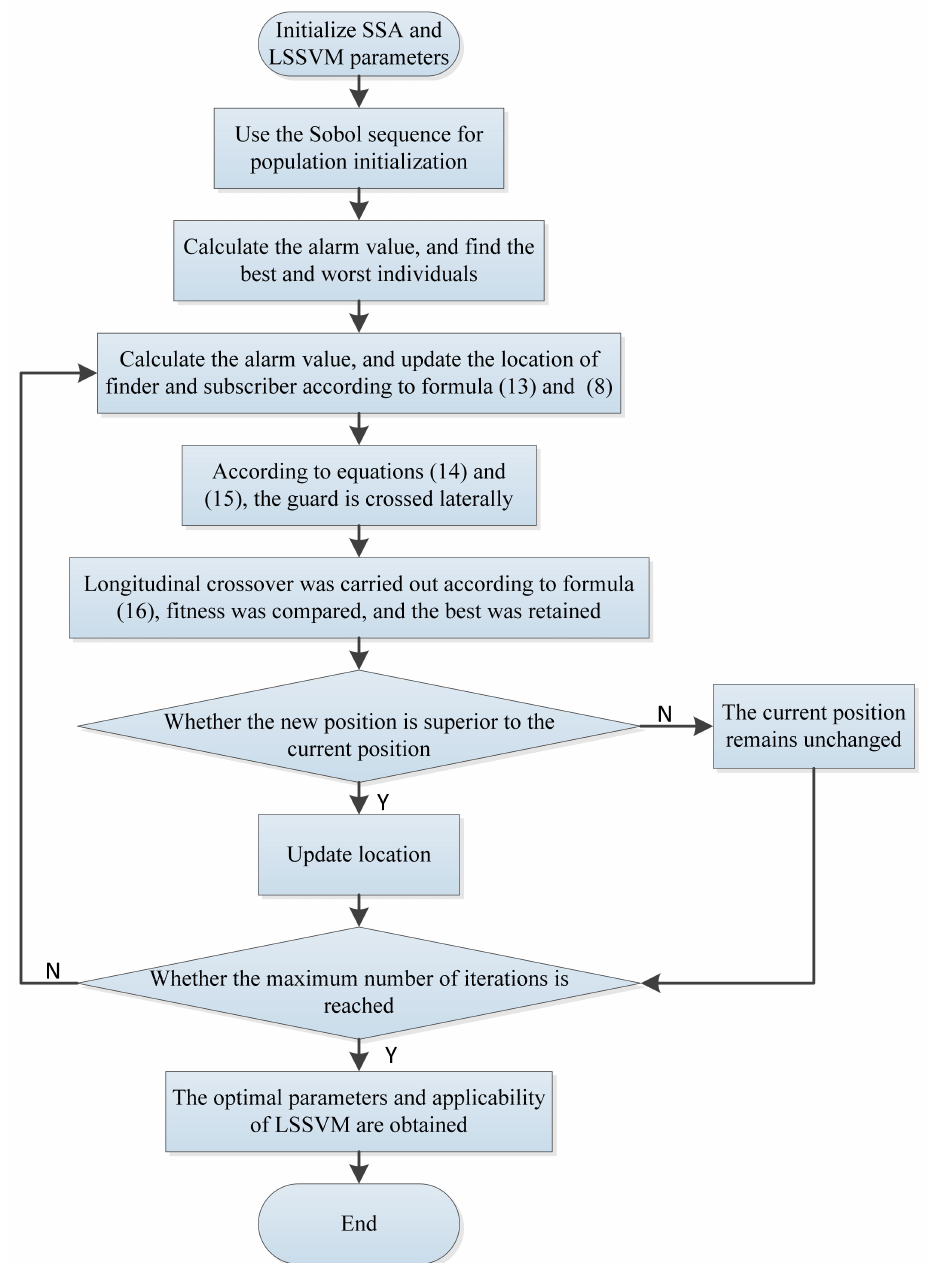
Figure 1. The flow chart of the